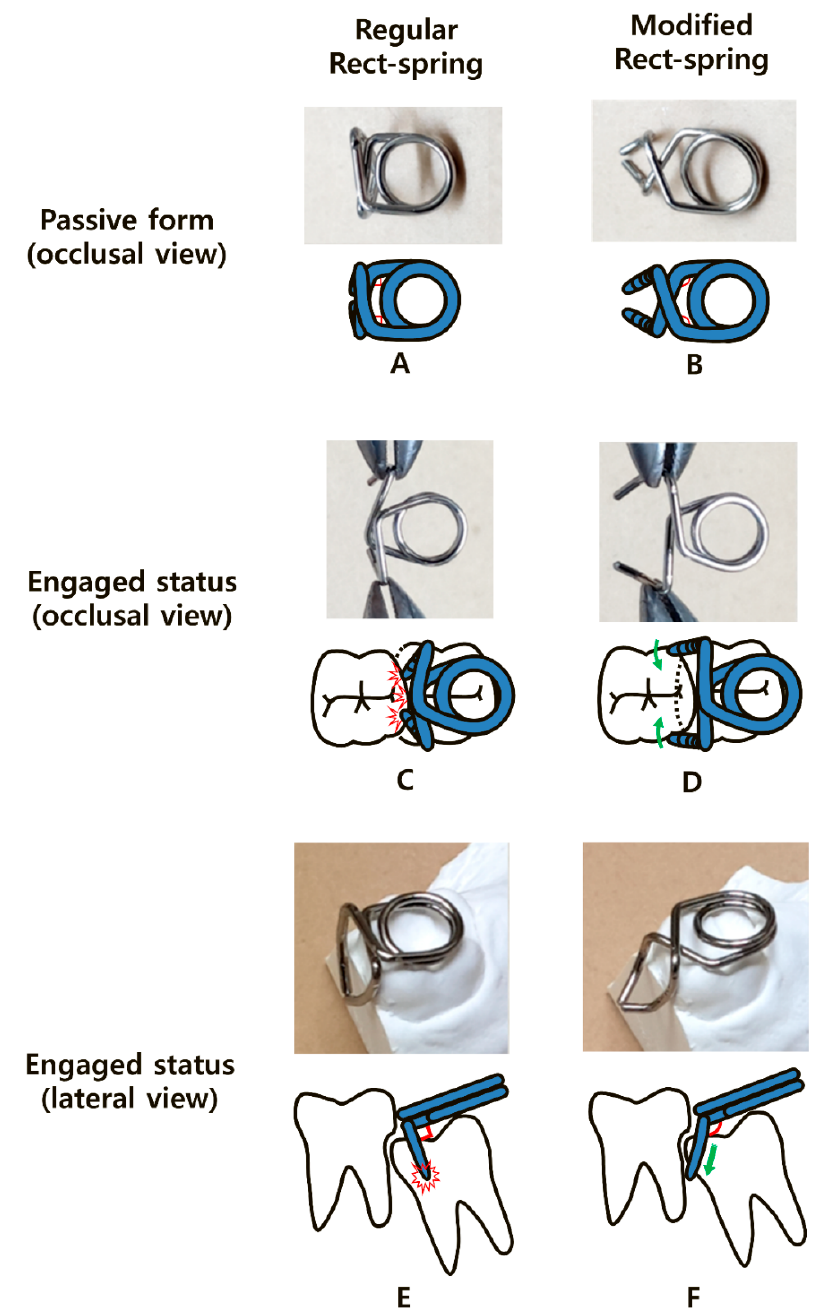
Figure 1. Comparison of different schematic views between the regular Rect-spring (RS) and modified Rect-spring (mRS), and the practical applications of each. ( A ) Perpendicular angles (red marks) of the RS. ( B ) Obtuse angles (red marks) of the mRS. ( C ) Unwanted retracting effect of the vertical arms during regular RS engagement, interfering with retention. ( D ) Wide opening of the vertical components of the mRS reduces the tension of the helical spring and enhances the distal movement of the locked molar on engagement. ( E ) The perpendicular angles (red angles) between the vertical and horizontal components cause unstable retention during engagement, with a risk of premature contact (red collision mark). ( F ) The obtuse angle (red angle) and curved arms engage the undercut of the locked molar (green arrow).